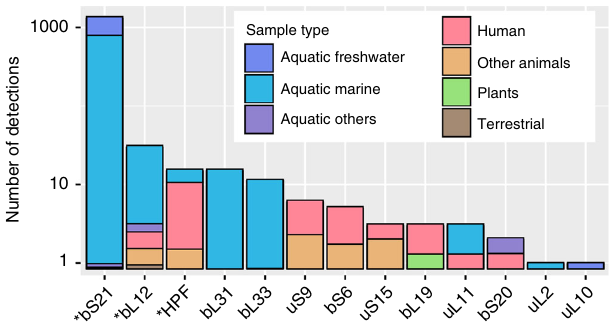
Fig. 2 Detection of ribosomal proteins in uncultivated viral genomes. For each ribosomal protein detected, the total number of detection is shown on the y -axis (log 10 scale), and the bar is colored according to the type of samples in which this protein was detected (the sizes of the colored parts are proportional to the number of detections made in each type of samples). Ribosomal proteins also identi fi ed in cultivated viruses